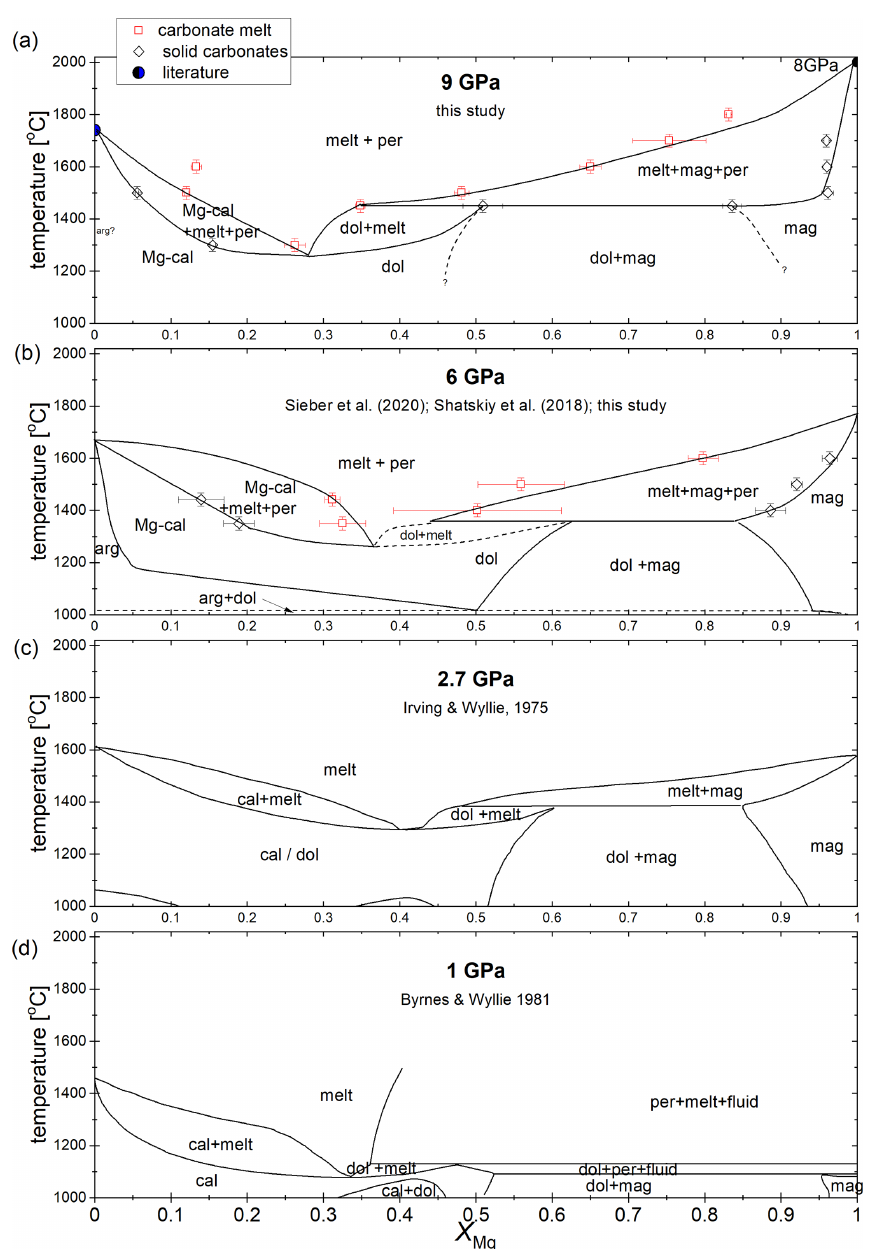
Figure 4. Phase relations in the CaCO 3 –MgCO 3 system at (a) 9GPa, (b) 6GPa, (c) 2.7GPa and (d) 1GPa; Abbreviations: arg, aragonite; cal, calcite; dol, dolomite; mag, magnesite; per, periclase.